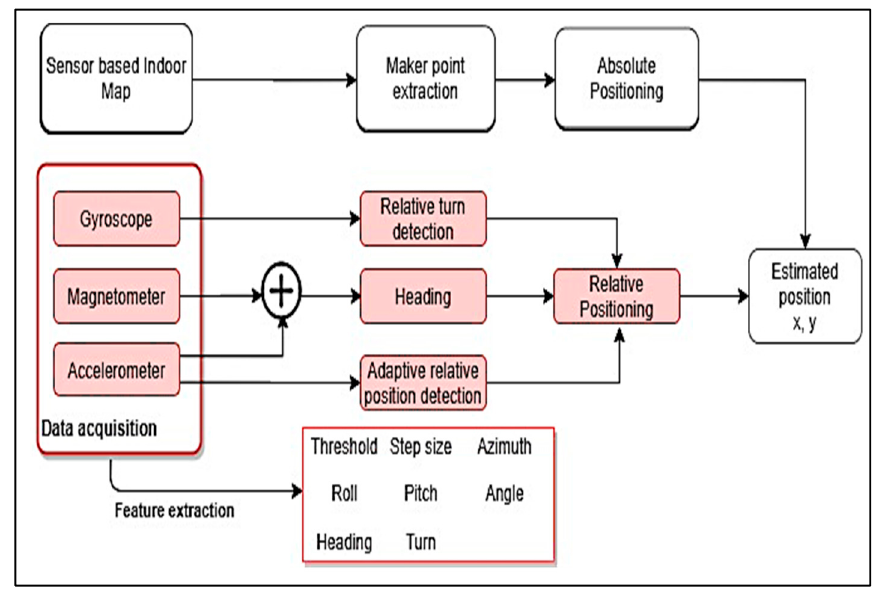
Figure 4. Framework of an indoor navigation system for VIP path by